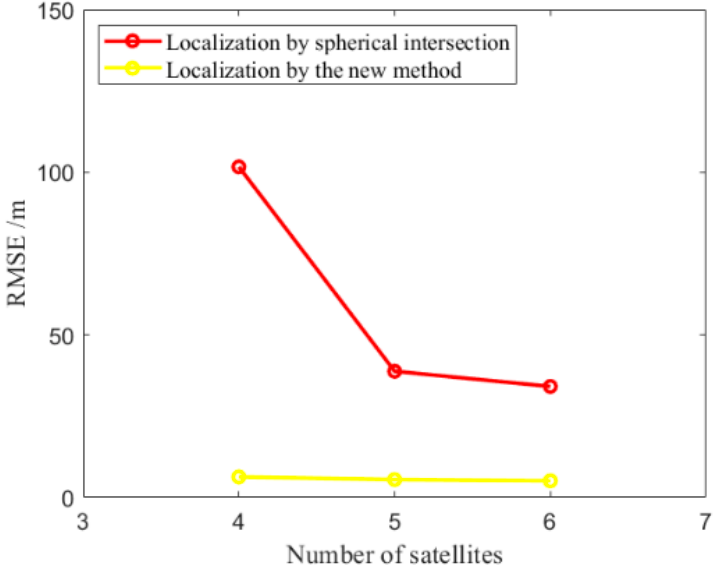
Figure 9. Localization error versus the satellite number.